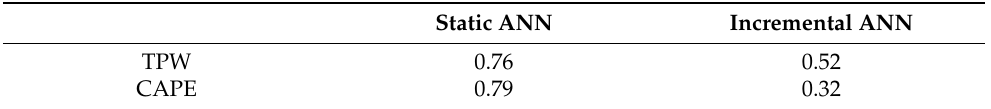
Figure 10. Model stability of ( a ) TPW and ( b ) CAPE depending on the learning method (ST and INC method) during the test period. The red is ST learning and the blue is INC learning. The solid and dotted lines are the bias and RMSE, respectively. Table 5. Autocorrelation values of the bias for the static and incremental ANN model in ELA region during test period. The time lag is set to one